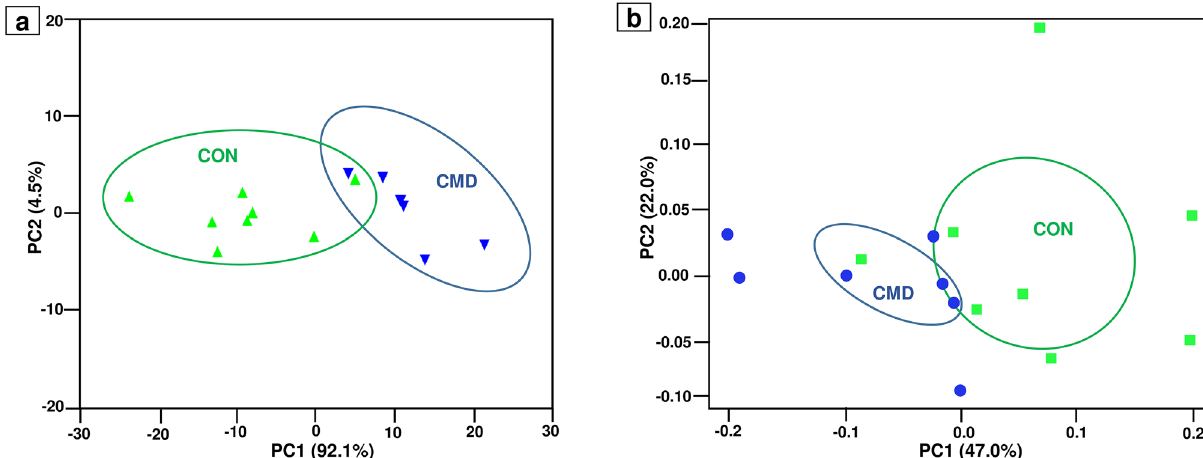
Figure 1. Principal coordinate analysis (PCoA) plot of (A) fatty acid profiles in rumen digesta (B) bacterial community structure in lambs fed the control diet (CON) and cardoon meal diet